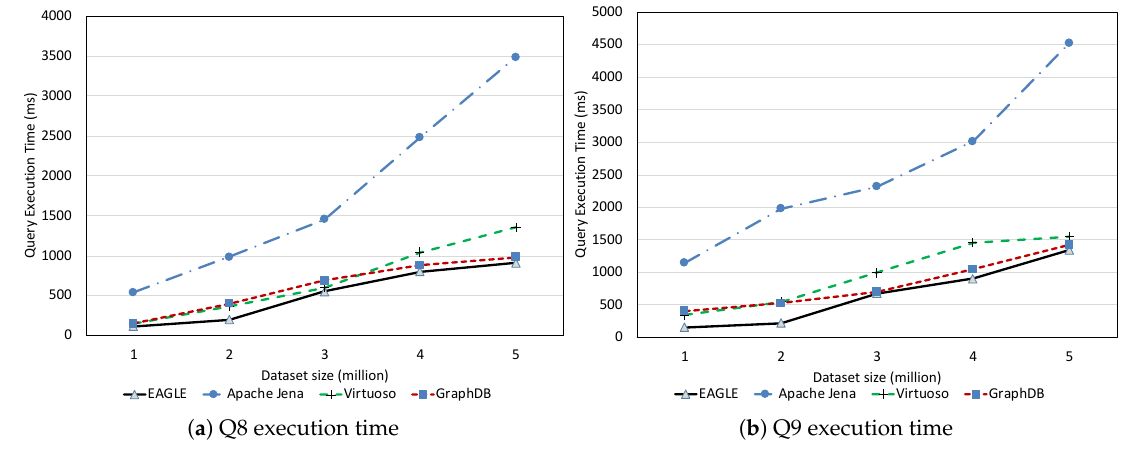
Figure 21. Text-search query execution times with respect to dataset